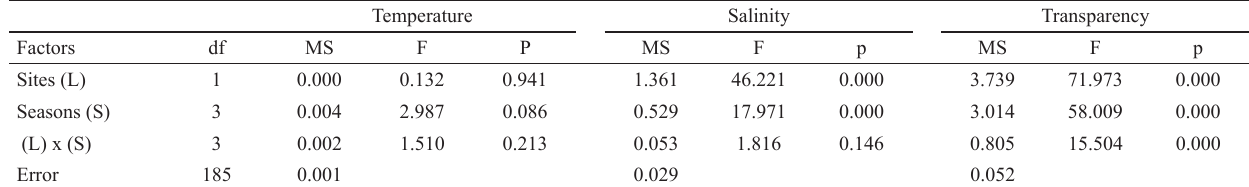
Table 2. F-values from two-way analysis of variance and comparisons (Tukey test) for environmental parameters in rio Mamanguape estuary, northeastern Brazil.